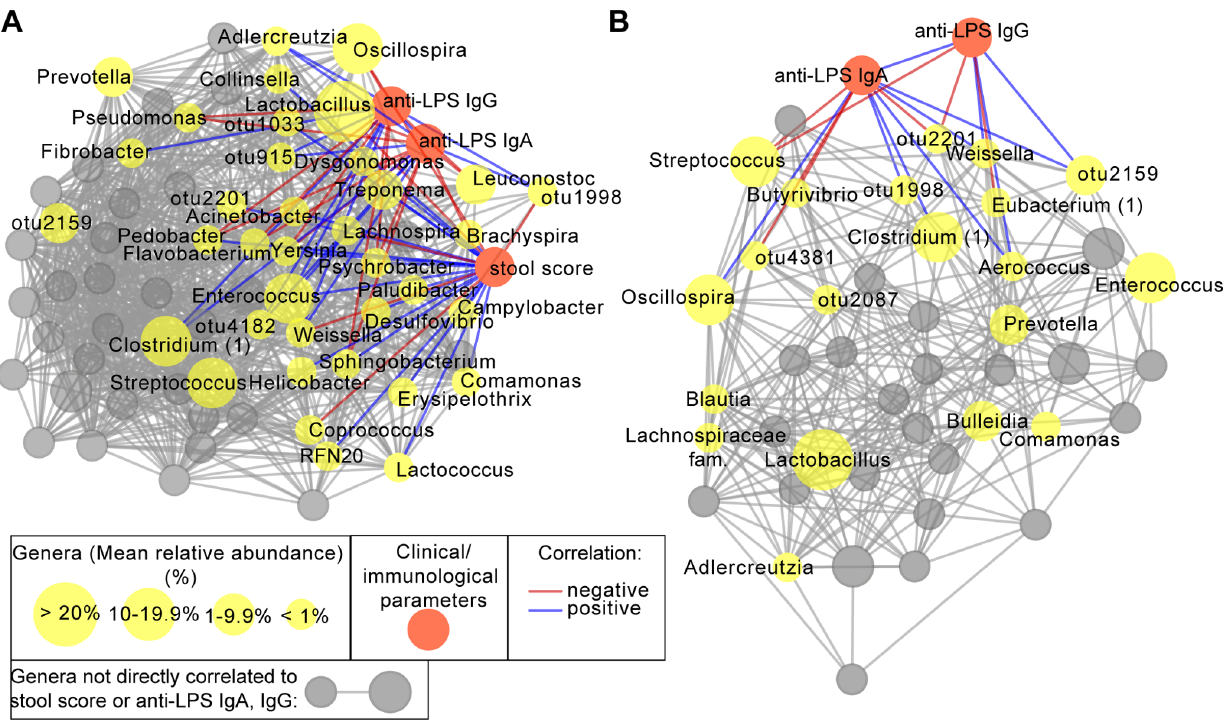
Figure 7. Local similarity analysis between genera and clinical and/or immunological measurements in macaque Shigella vaccine studies. Networks of significant correlations (p , 0.01; q . 0.40) using local similarity analysis between genera and the immunological or clinical measurements in macaques in ( A ) study 1 and ( B ) study 2. Nodes are colored as described in boxed inset (genera sized for relative abundance). Correlations among non-core genera and genera not directly related to immunological or clinical measurements have been greyed out.